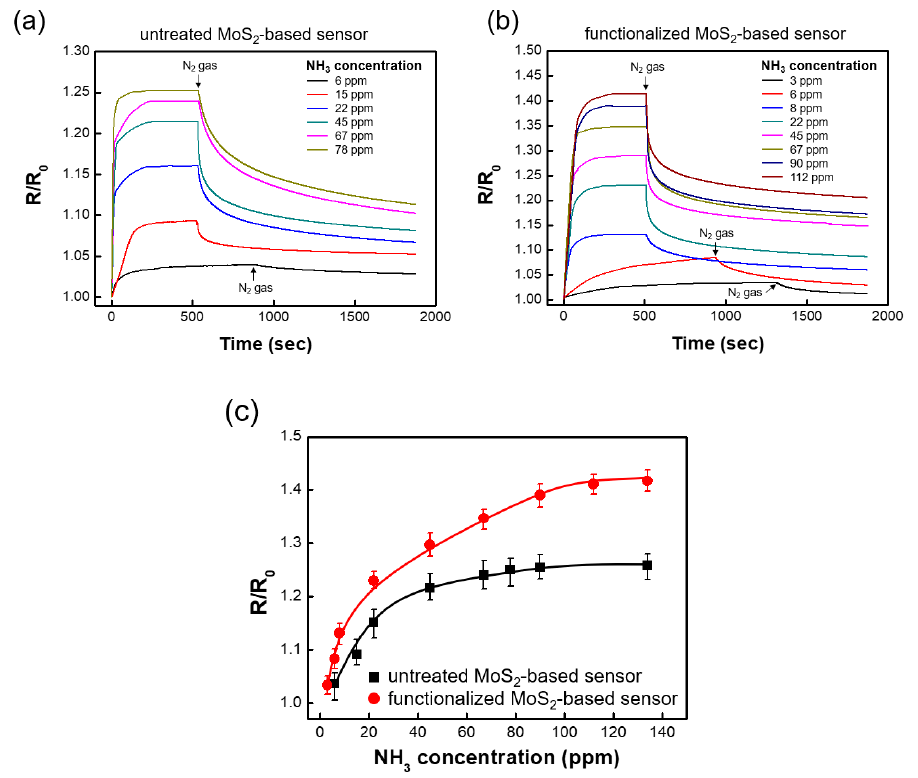
Figure 6. Responses of ( a ) untreated and ( b ) functionalized MoS 2 -based sensors for di ff erent NH 3 concentrations at room temperature. ( c ) Variation in R / R 0 of the MoS 2 films exposed to di ff erent NH 3 concentrations, where R 0 is the resistance of the device in the outgassed state and R is the steady-state resistance when exposed to the NH 3 gas.